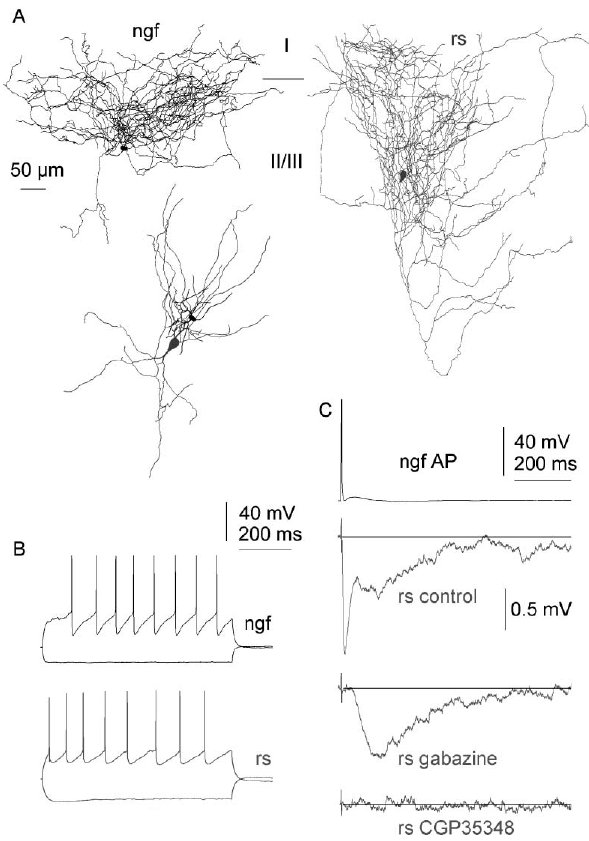
Figure4. GABAAandGABABreceptorsmediateneurogliaformcells(ngfc) toregularspikinginterneuron(rs)connections .( A )Three-dimensionallight microscopic reconstructions of the presynaptic neurogliaform cell (black) and the postsynaptic regular spiking interneuron (gray). Axonal (left and right) and dendritic (middle) reconstructions are separated for clarity, the relative position of the two cells is shown by the dendritic arborizations. ( B ) Firing patterns of the two cells. ( C ) Single action potentials in the neurogliaform cell elicited slow IPSPs with two components in the regular spiking interneuron. TheearlycomponentcouldbeblockedbytheGABAAreceptorblockergabazine (10 µ M) and the late phase of IPSP was abolished by the subsequent addition of CGP35348 (60 µ